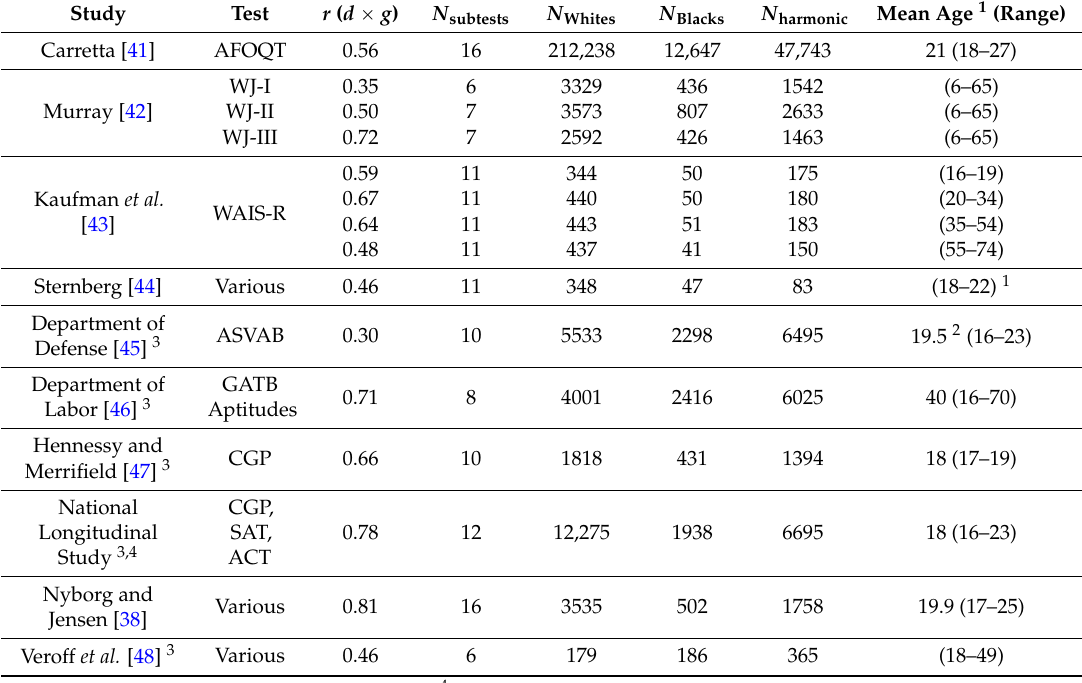
Table 3. Studies of Correlations between g Loadings and Adult Black/White Differences.